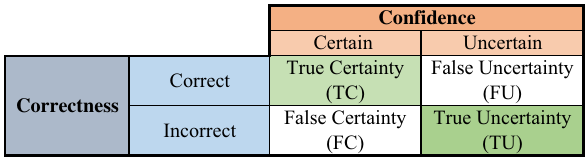
Figure 1. The uncertainty confusion